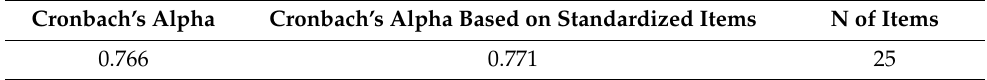
Table 4. Reliability Statistics.